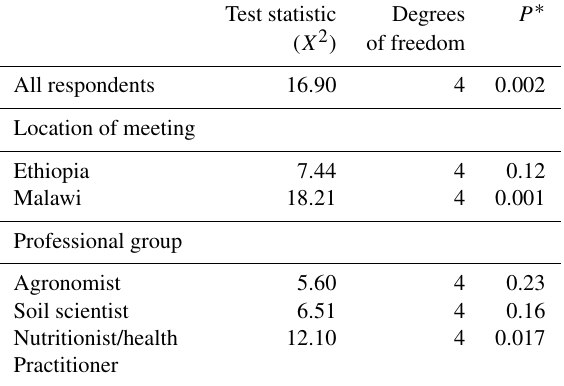
Table 10. Analysis of Q7 according to all the respondents, the lo- cation of the meeting and the professional